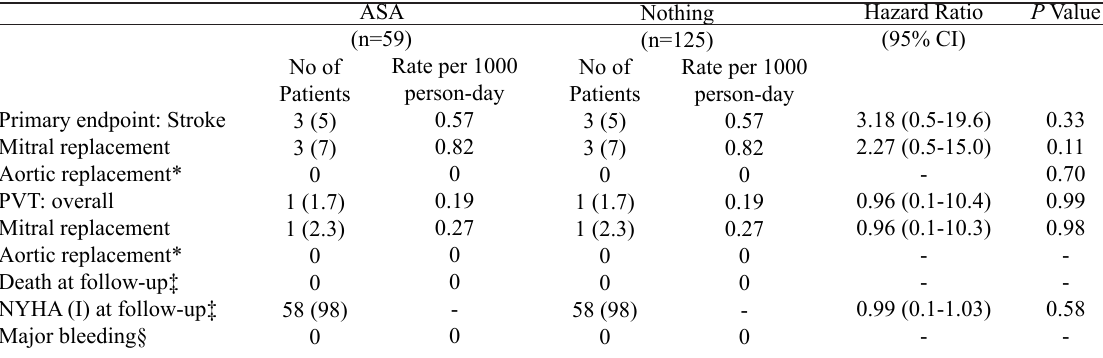
Table 2. Outcomes according study